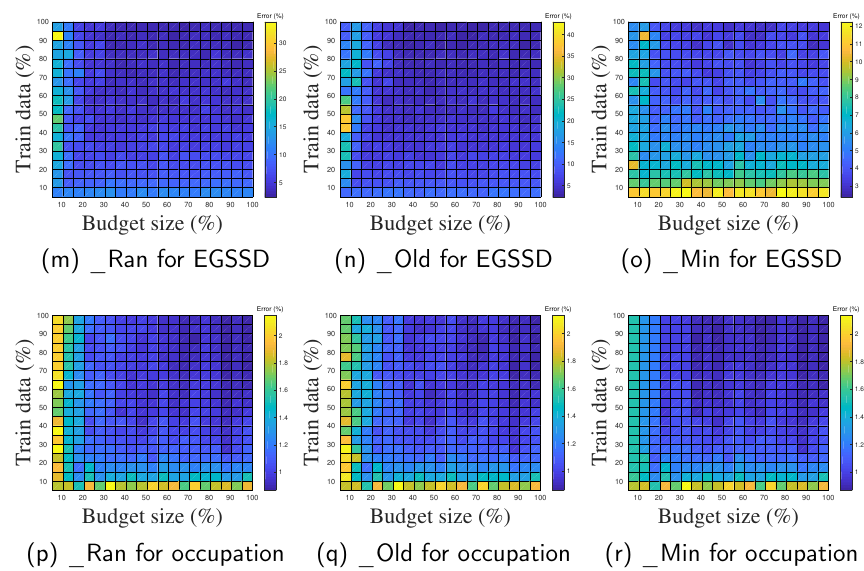
Figure 9. Error with varying budget size and training